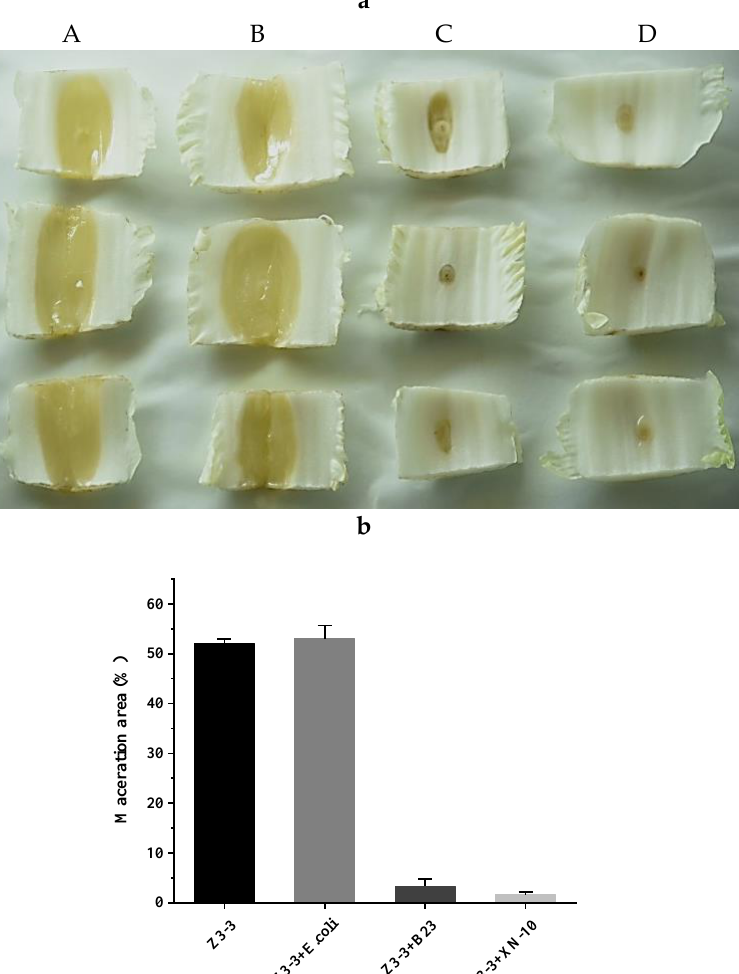
Figure 8. Biocontrol test of strain XN-10 against Pectobacterium carotovorum subsp. carotovorum ( Pcc ) on Chinese cabbage under laboratory conditions. ( a ) Attenuated maceration of Pcc strain Z3-3 by strain XN-10 on Chinese cabbage. A: inoculation of Z3-3 alone; B: co-inoculation of Z3-3 and Escherichia coli DH5 α ; C: co-inoculation of Z3-3 and Bacillus thuringiensis subsp. israelensis B23; and D: co-inoculation of Z3-3 and strain XN-10. ( b ) Tissue maceration rates in each treatment.